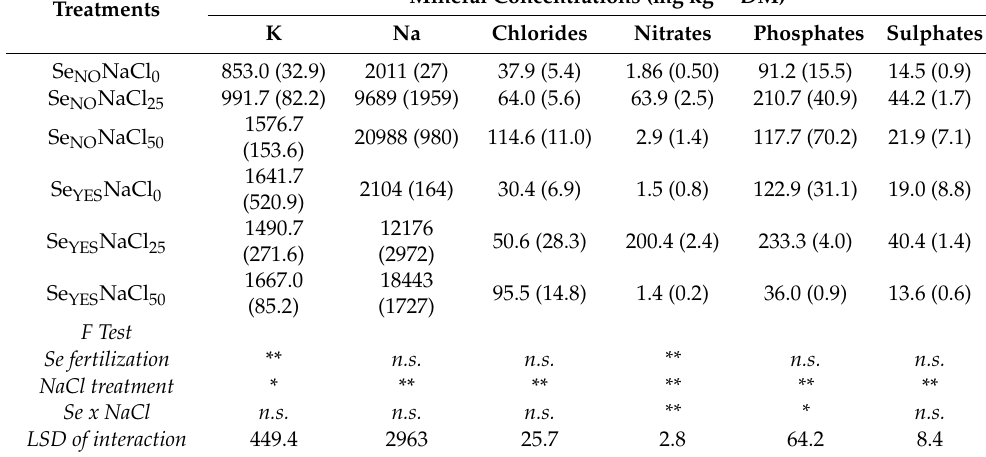
Table 3. Mineral concentrations in shoots of maize sprouts obtained at 0, 25, or 50 mM NaCl (i.e., NaCl 0 , NaCl 25 , and NaCl 50 , respectively) from grains produced without or with Se fertilization (i.e., Se NO and Se YES ,